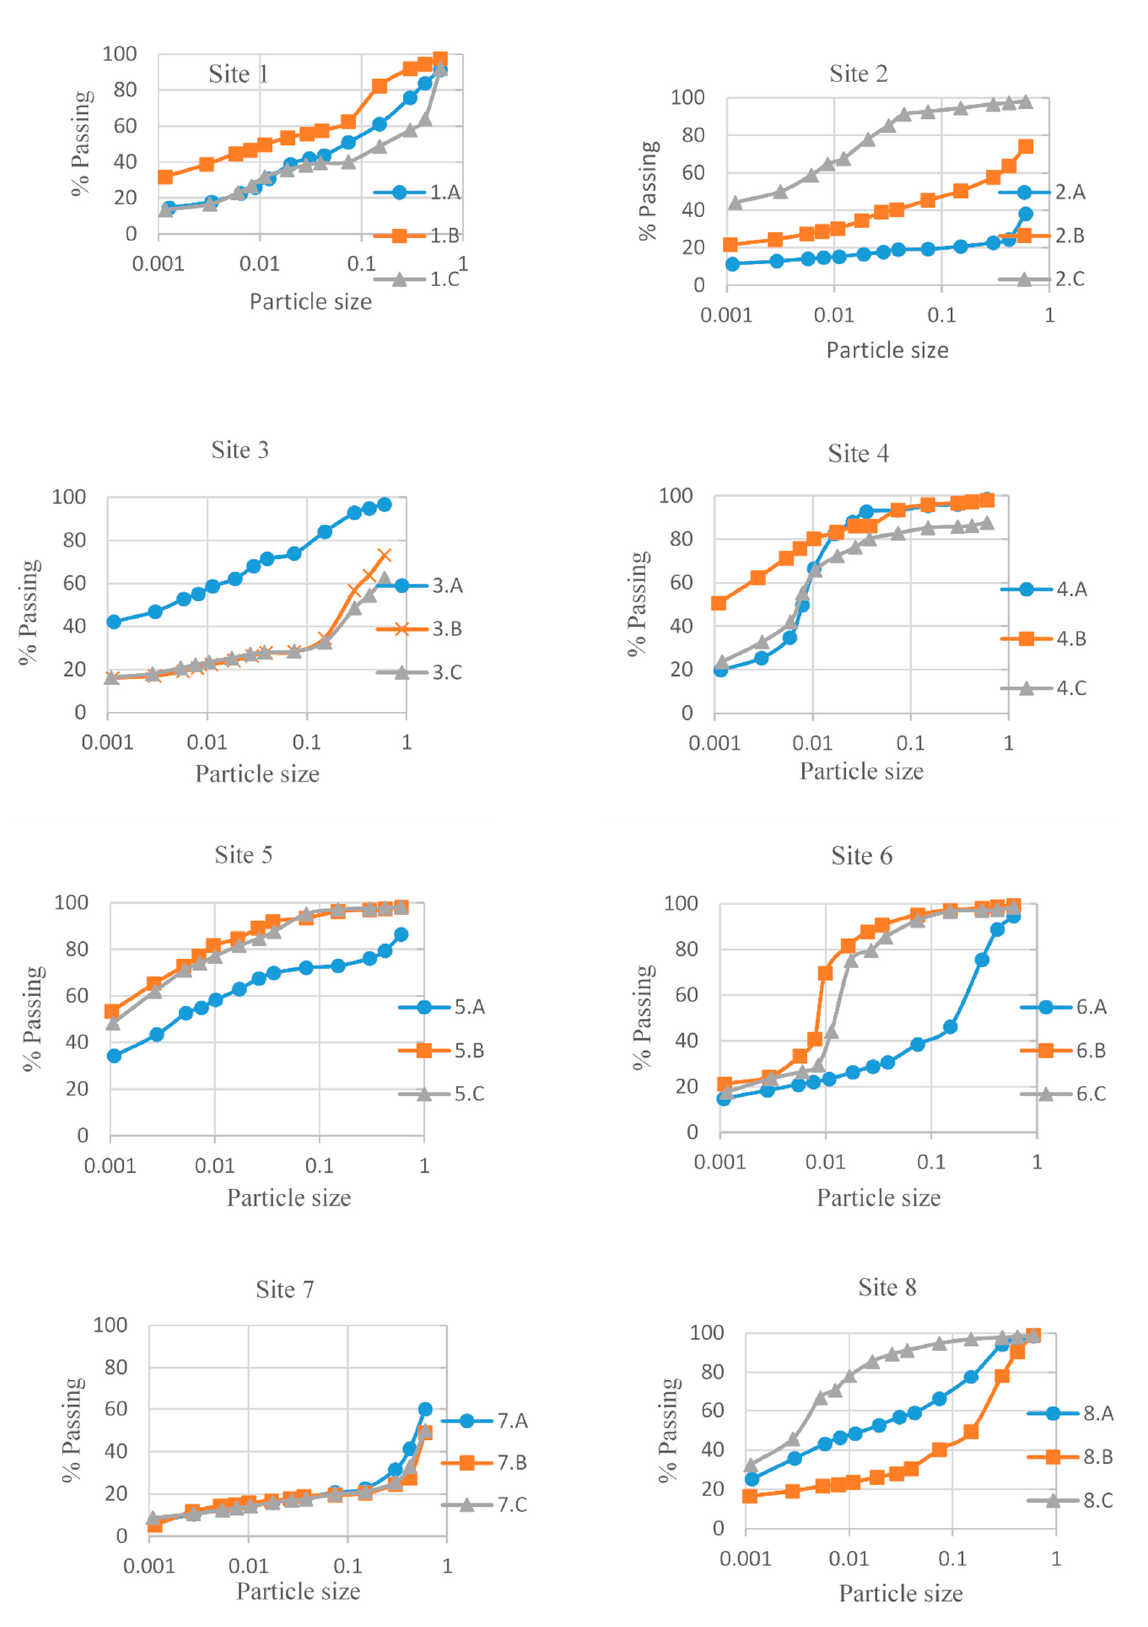
Figure 2. Grain-size analysis of salt marsh soils across eight Georgia sites using sieve and hydrometer methods.